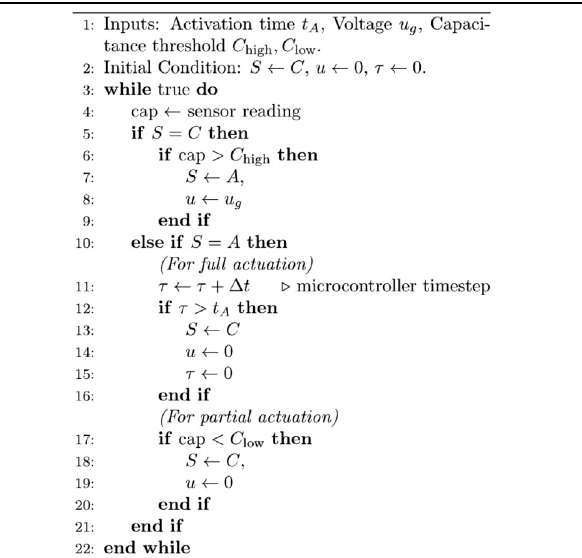
Algorithm 1 Bang-Bang Cyclical Actuation